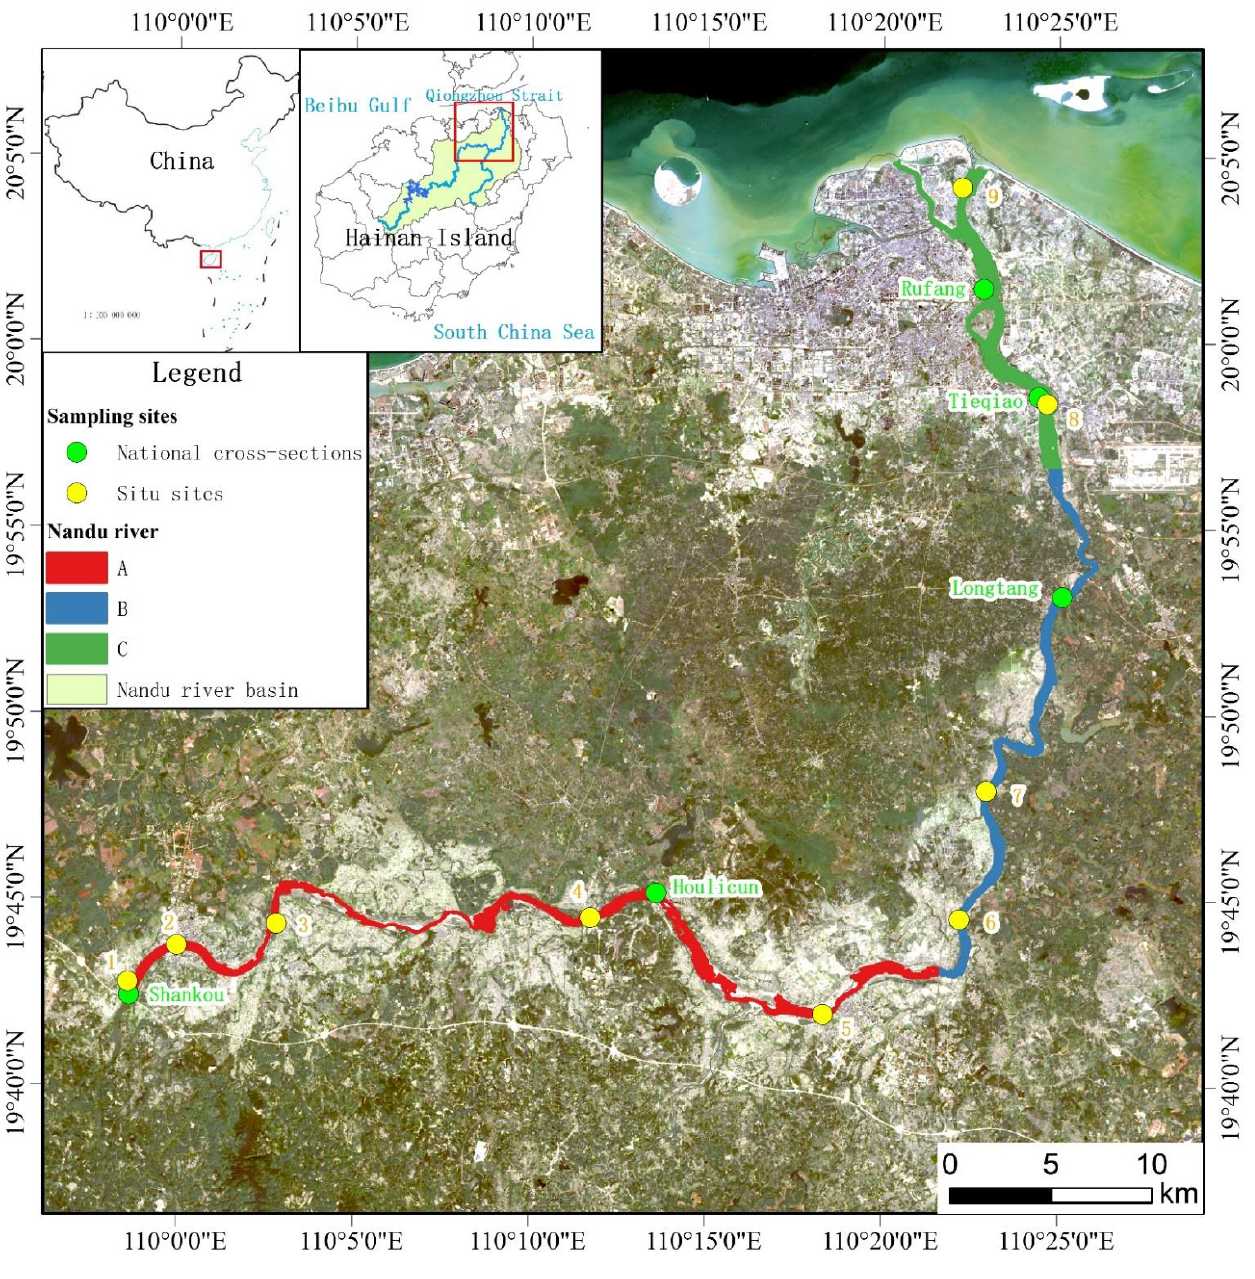
Figure 1. Location of the Nandu River downstream and distribution of sampling sites. The map of China is produced under the supervised by the Ministry of Natural Resources of China with the map content approval number: GS(2016)1554.